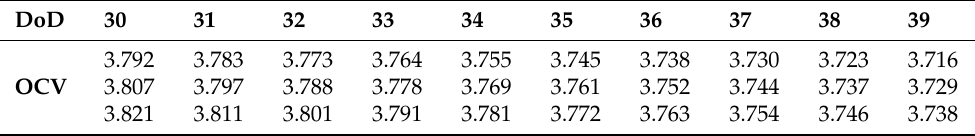
Table A4. OCV models parameters for DoD from 30% to 39%.